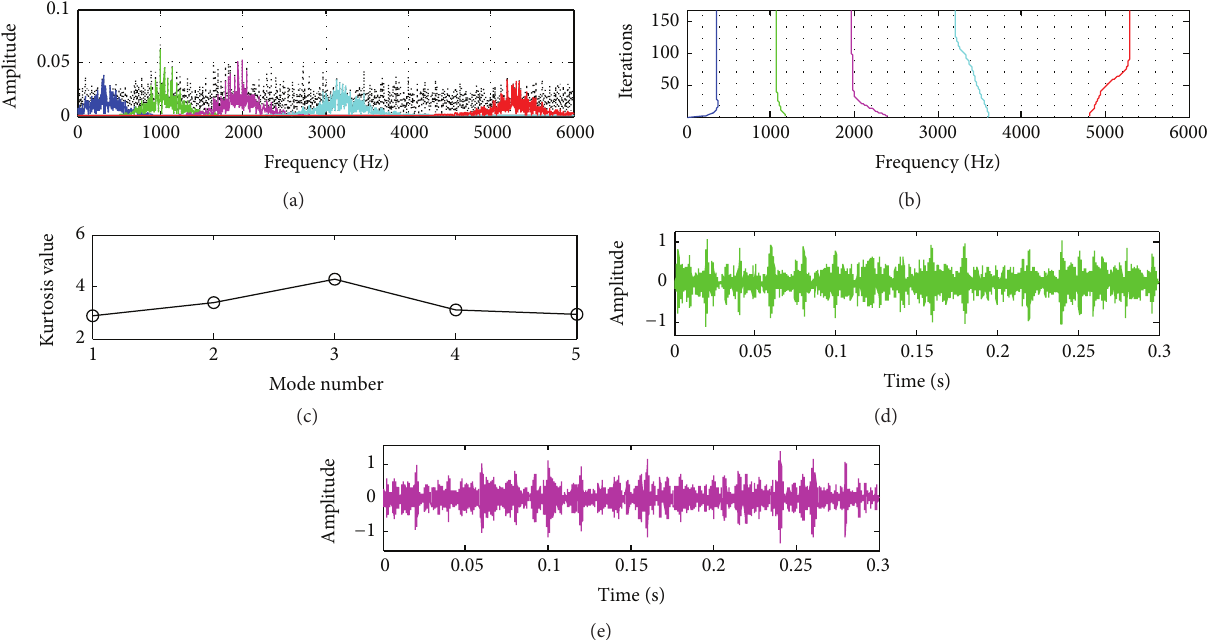
Figure 10: Analyzed results of the simulated signal with double resonance bands shown in Figure 8(b) by the proposed method: (a) power spectrumobtainedbyVMD;(b)thenumberofiterationswithcentralfrequencies;(c)kurtosiscurveoffivedecomposedmodes;(d)waveform of second mode with the second maximum kurtosis value; (e) waveform of third mode with the maximum kurtosis